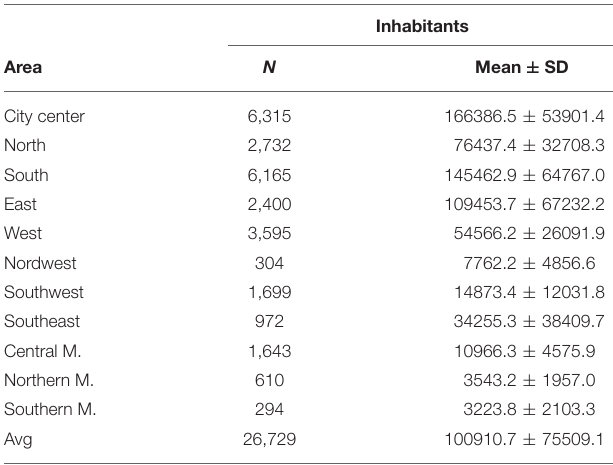
TABLE 1 | Inhabitants per area in Madrid